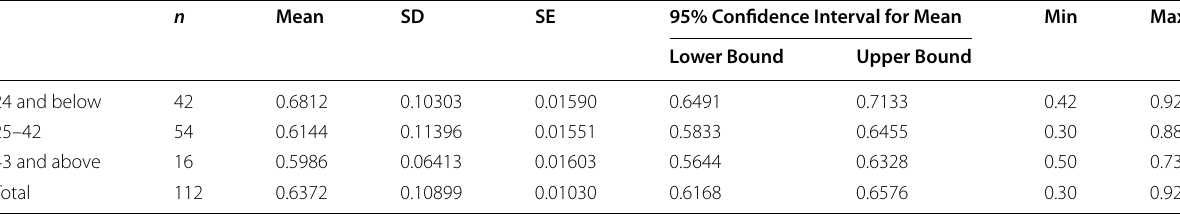
Table 4 Tukey’s HSD post hoc test about lifestyles of COVID-19 score according to respondents’ age